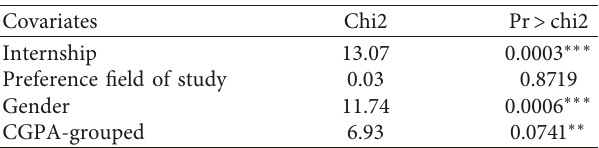
Table 5: Log-rank test for equality of survivor functions for various covariates.